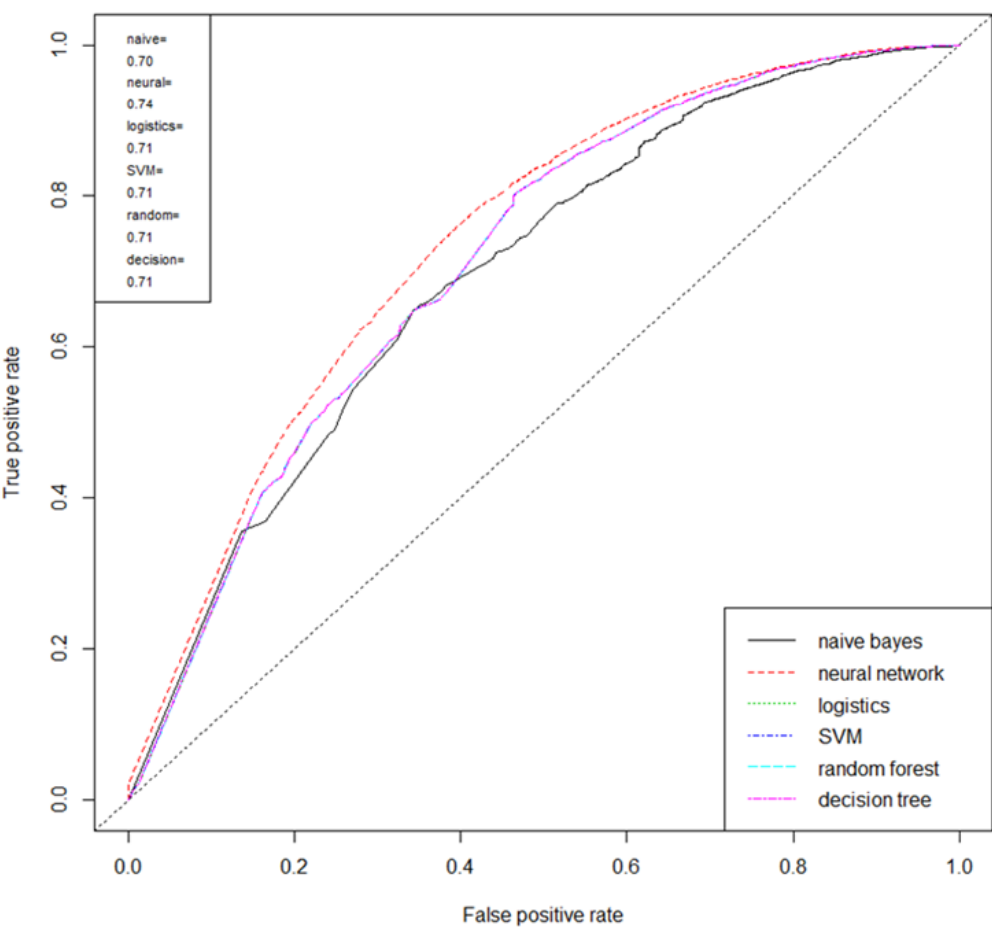
Figure 3. Random Forest Model of Cause-and-Disease Factor.